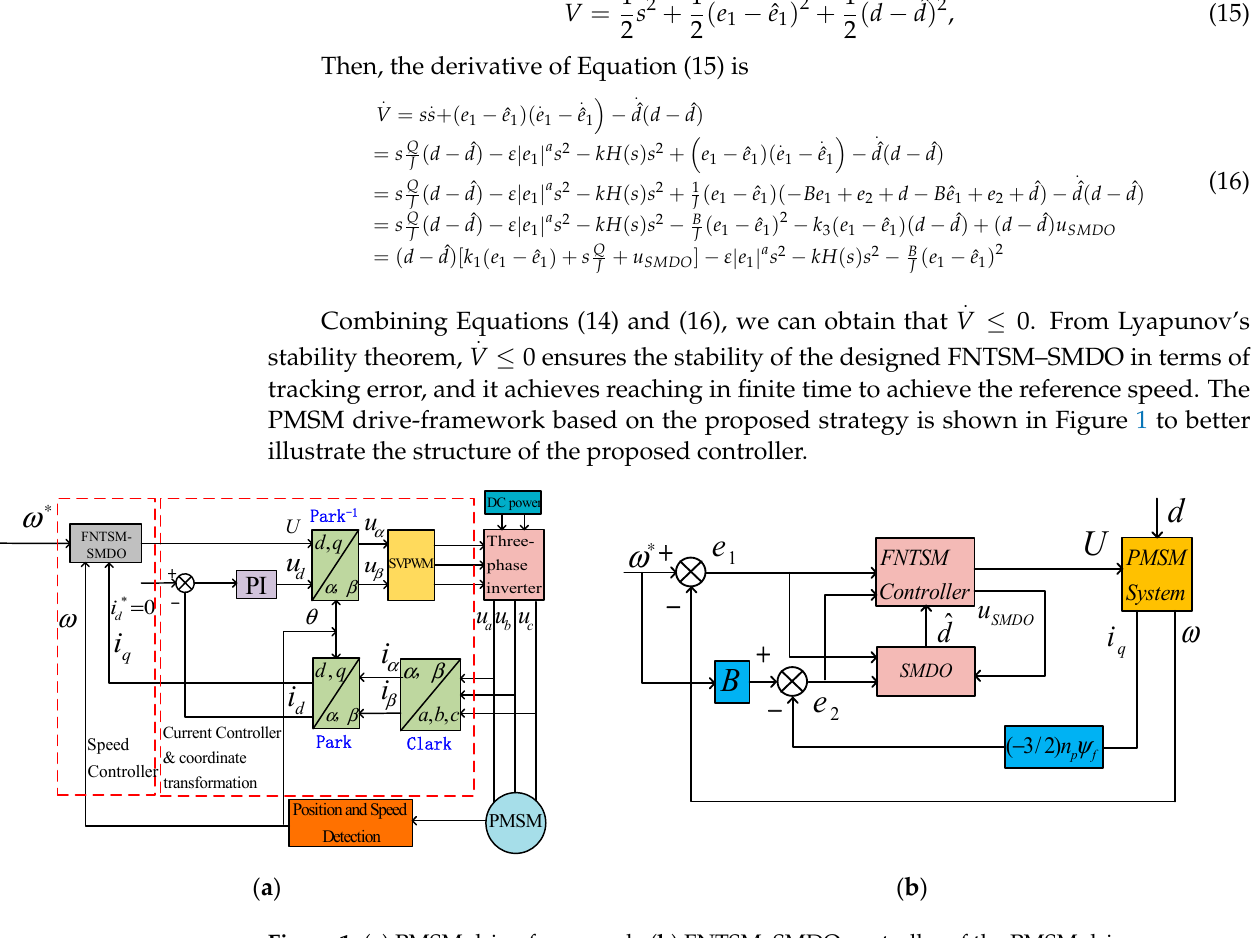
Figure 1. ( a ) PMSM drive-framework, ( b ) FNTSM–SMDO controller of the PMSM drive.